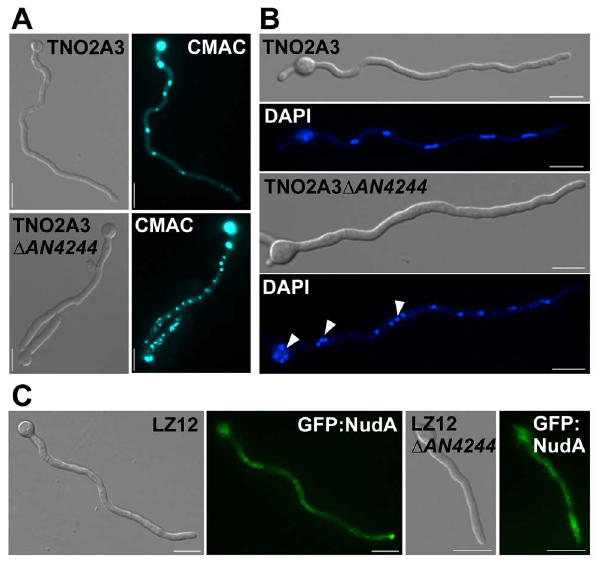
Figure 7. Deletion of the gene for a Num1-homologue in the ascomycete Aspergillusnidulans leads to a phenotype reminis- cent to the D num1 phenotype in U.maydis . ( A ) The morphology of vacuoles is affected by the AN4244 -deletion. Spore suspensions of a wild-type (TNO2A3) and the AN4244 deletion mutant were incubated for 18 hours at 37 u C and the germinated filaments were CellTracker Blue (CMAC)-stained to visualize the vacuoles. Similar to the num1 - deletion in U. maydis , the AN4244 -deletion in A. nidulans leads to an increased number of vacuoles. ( B ) Deletion of AN4244 affects nuclear positioning. Spore suspensions of A. nidulans wild-type (TNO2A3) and the AN4244 deletion mutant were incubated for 12 and 18 hours, respectively, at 37 u C, and the germinated filaments were DAPI-stained to visualize nuclei. In wild-type filaments, nuclei are evenly spaced, whereas in the mutant nuclei are often found in clusters. ( C ) The localization of Dynein (NudA) is dependent on AN4244. Spore suspensions of strains LZ12, expressing a GFP:NudA fusion protein, and LZ12 D AN4244 were incubated for 18 hours at 37 u C. In LZ12 the GFP:NudA signal strongly accumulated in tips of germinating hyphae, whereas in mutant filaments, this apical accumulation was reduced; instead a stronger signal was observed in the cytoplasm. Scale bars: 10 m m.